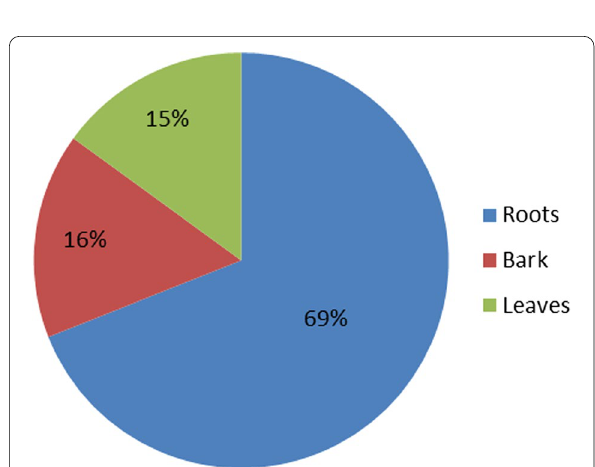
Fig. 3 Percentage of plant parts used by the herbalist and non-herbalist for TB remedy in Kitgum and Pader districts, Uganda